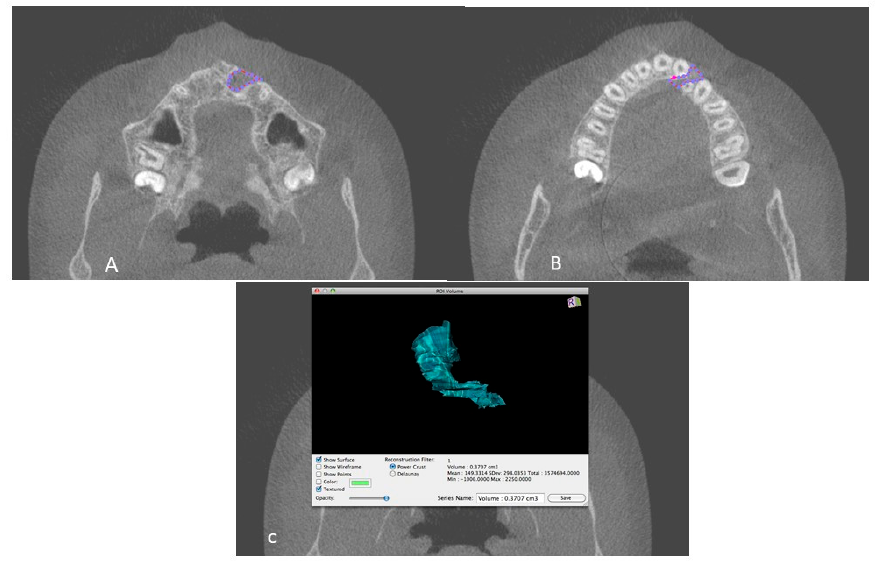
Figure 2. ( A , B ) Defect demarcation on the axial slice using drawing tool of OsirixDicom Viewer (Pixmeo Inc.); ( C ) Volume of the defect calculated by Osirix software.